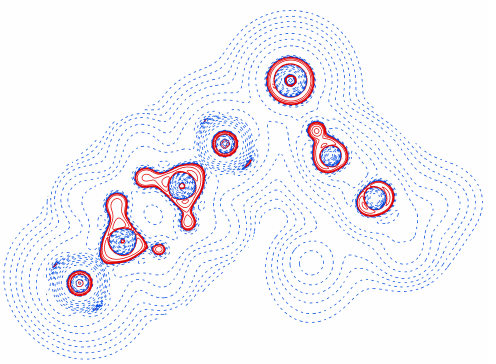
Figure 9. Laplacian of the electron density in 2 ; positive values in blue, negative values in red, contours at ± 2 n · 10 − 3 a.u. (0 ≤ n ≤ 20).